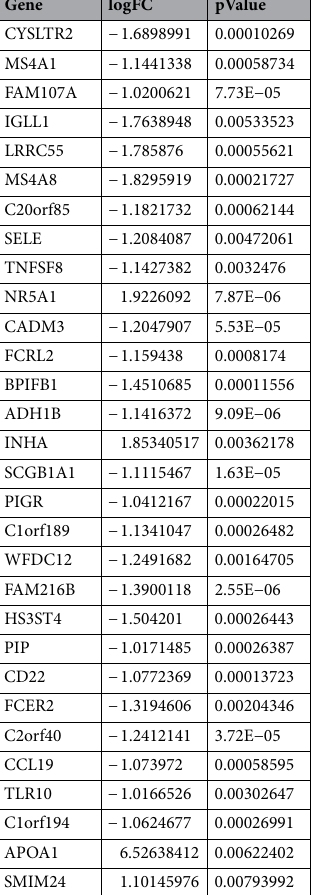
Table 1. Differential expressed genes between low TMB and high TMB